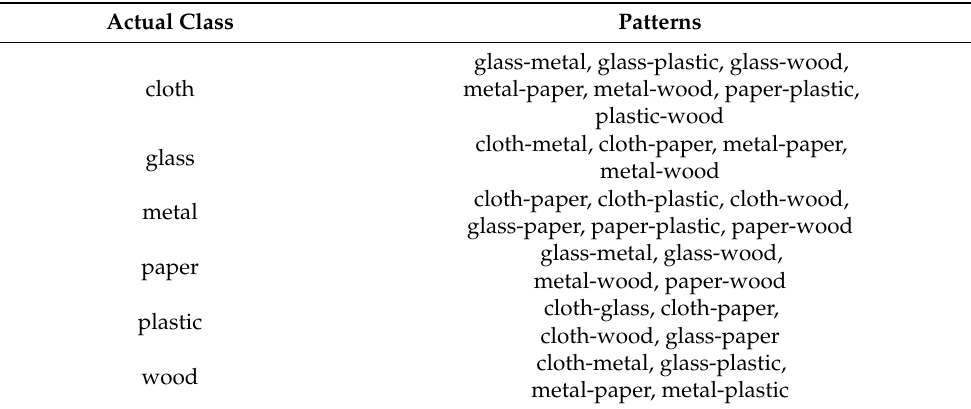
Table 7. Combinations capable of correct perception.